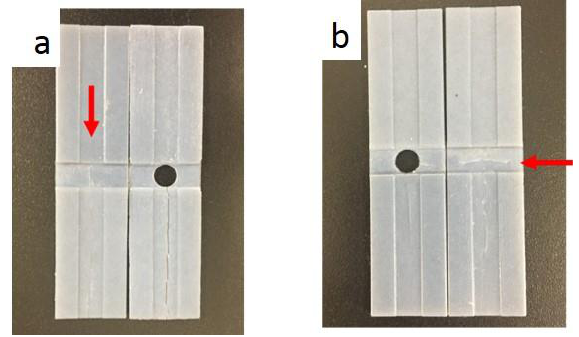
Figure 22. Fracture for the 0.3 mm sample ( a ) After repeating method 1; ( b ) After repeating method 2.